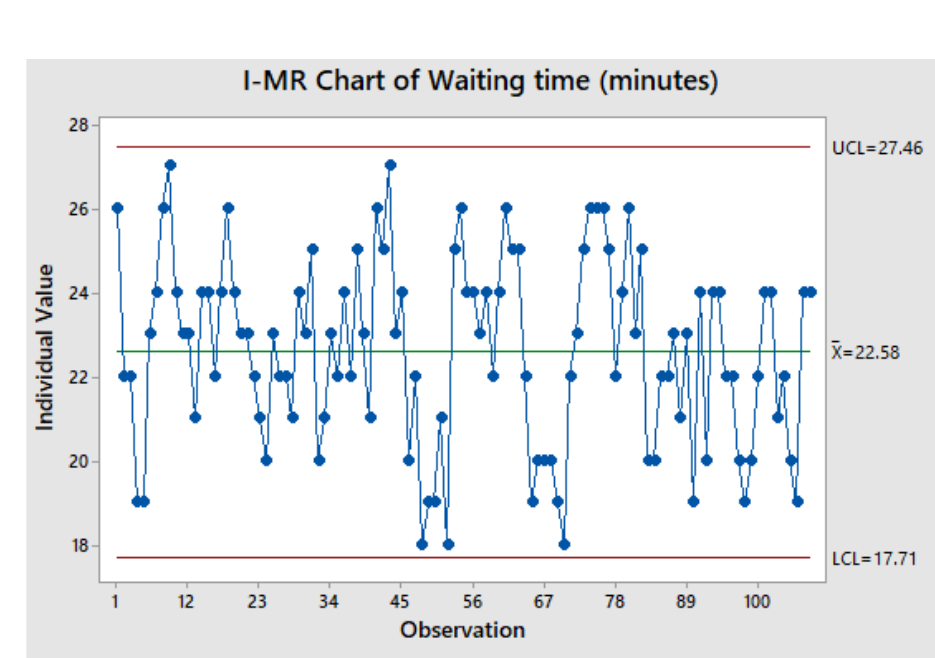
Figure 4. Modified I-MR chart for waiting time